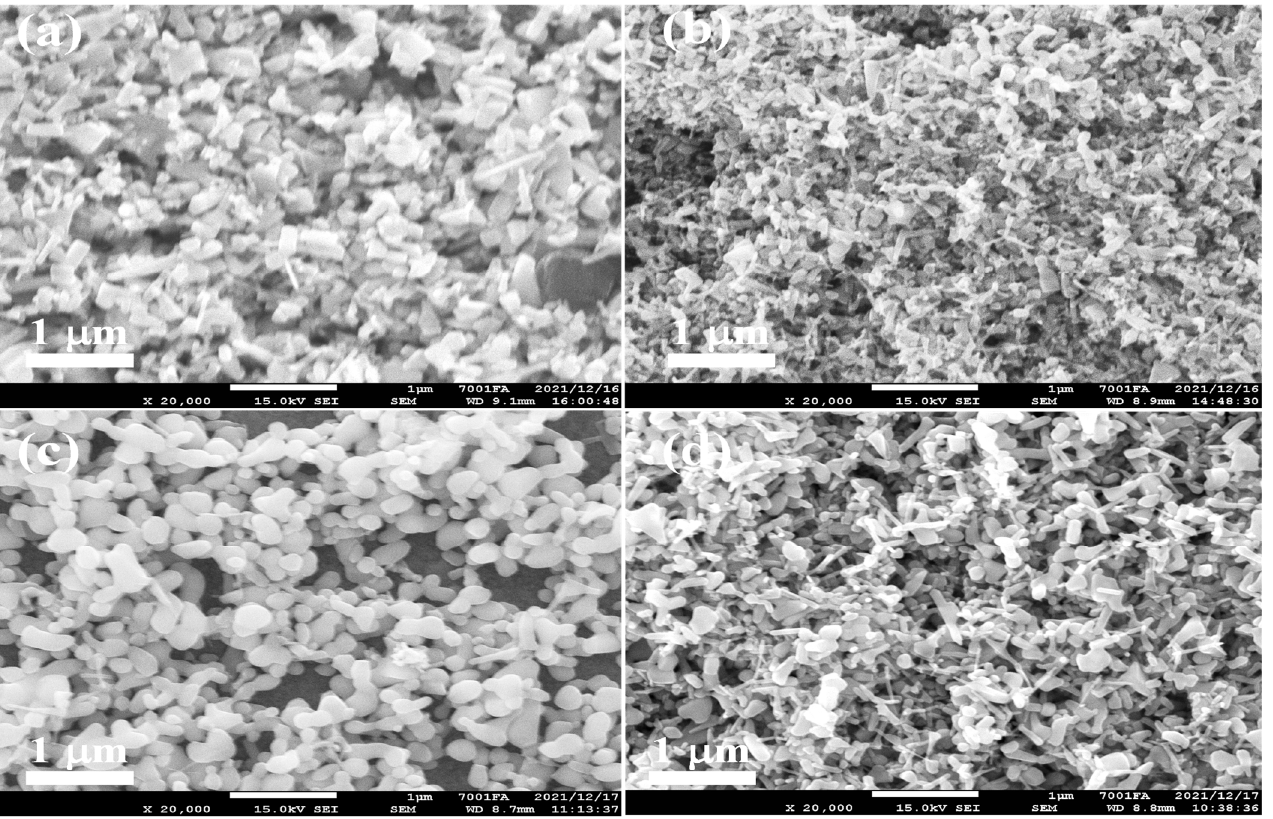
Figure 2. SEM image of the ( a ) as-synthesized ZnO NPs, ( b ) as-prepared ZnO, ( c ) ZnO:Ga-open air, and ( d ) ZnO-open air.